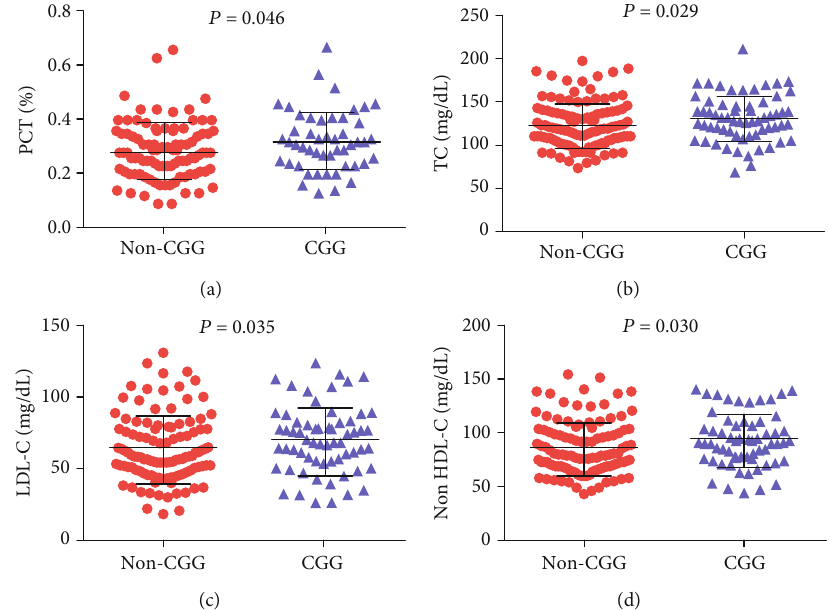
Figure 5: Associations between the CGG haplotype and laboratory parameters in individuals with SCD. Carriers of the CGG haplotype presented increased levels of (a) plateletcrit (PCT), (b) total cholesterol (TC), (c) low-density lipoprotein cholesterol (LDL-C), and (d) nonhigh-density lipoprotein cholesterol (non-HDL-C) ( P values obtained by the Mann-Whitney U